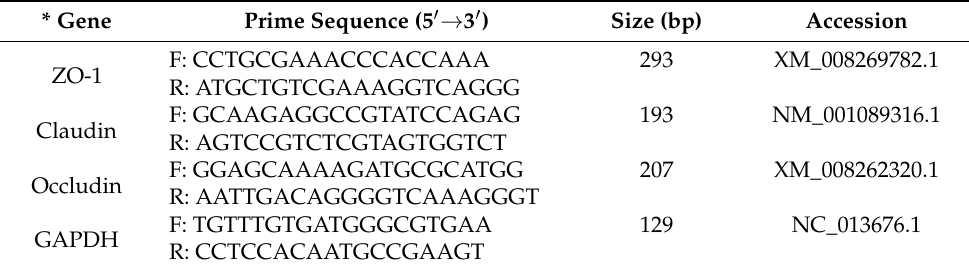
Table 3. Primer sequences for genes for